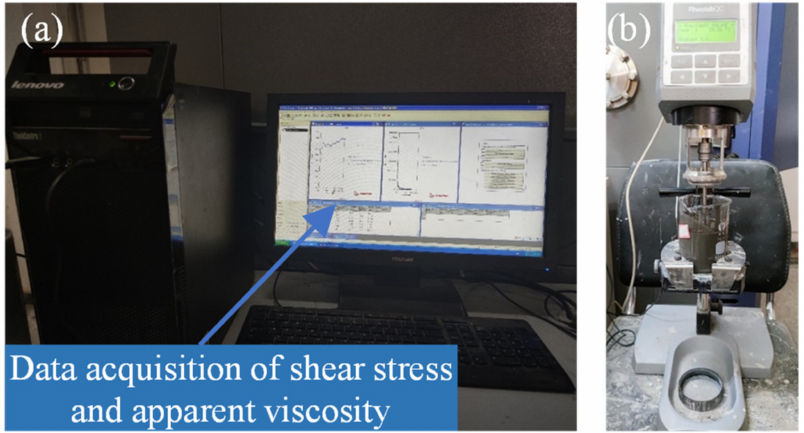
Figure 1. R/S four-blade paddle rotary rheometer. ( a ) The control system; ( b ) The testing